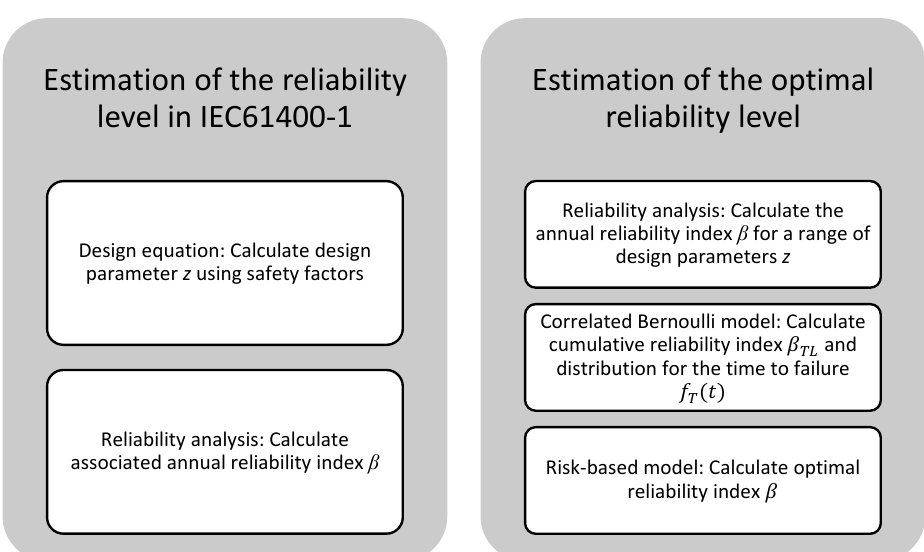
Figure 1. Overview of the method. The design equation is described in Section 2.1, the reliability analysis in Section 2.2, the correlated Bernoulli model in Section 2.3, and the risk-based model in Section 2.4.